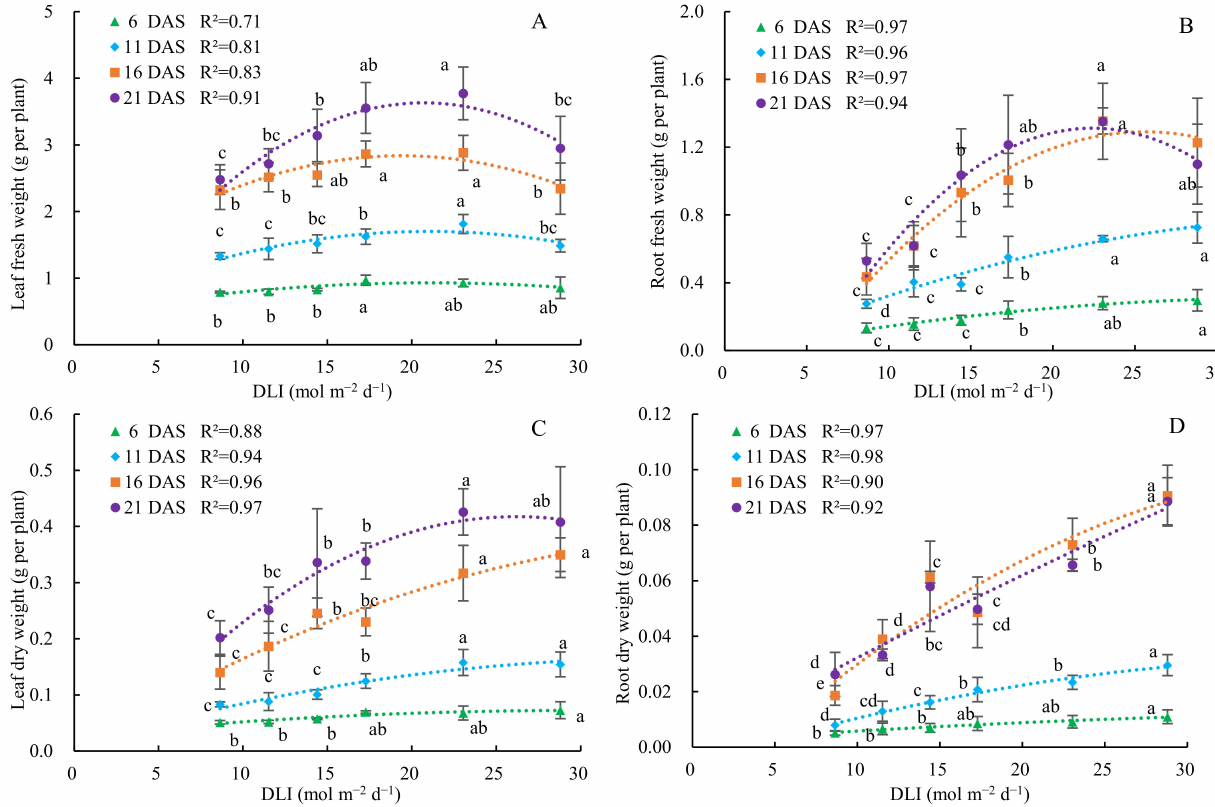
Figure 3. Relationship between daily light integrals (DLI) and ( A ) leaf fresh weight, ( B ) root fresh weight, ( C ) leaf dry weight, and ( D ) root dry weight of cucumber seedlings at 6, 11, 16, and 21 days after sowing (DAS) in a closed transplant production system. Data are presented as mean ± standard deviation. Different letters indicate significant differences at p <